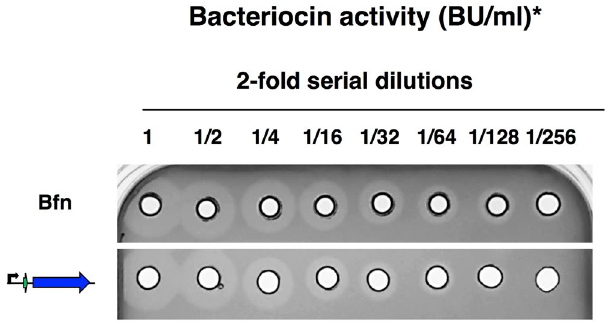
Figure 6. Quantification of the expression of bactofencin A produced by E . coli Tuner (DE3) transformed with the plasmid containing the structural and the transporter encoded genes after 3 h of 100 µ M ITPG induction. The activity of the supernatant from an overnight culture of Lb . salivarius is indicated as Bfn. * Bacteriocin activity (BU/ml) was calculated as the inverse of the highest dilution showing inhibition of Lb . bulgaricus indicator strain divided by volume (0.05